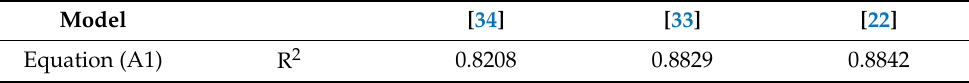
Table 21. Comparison with other